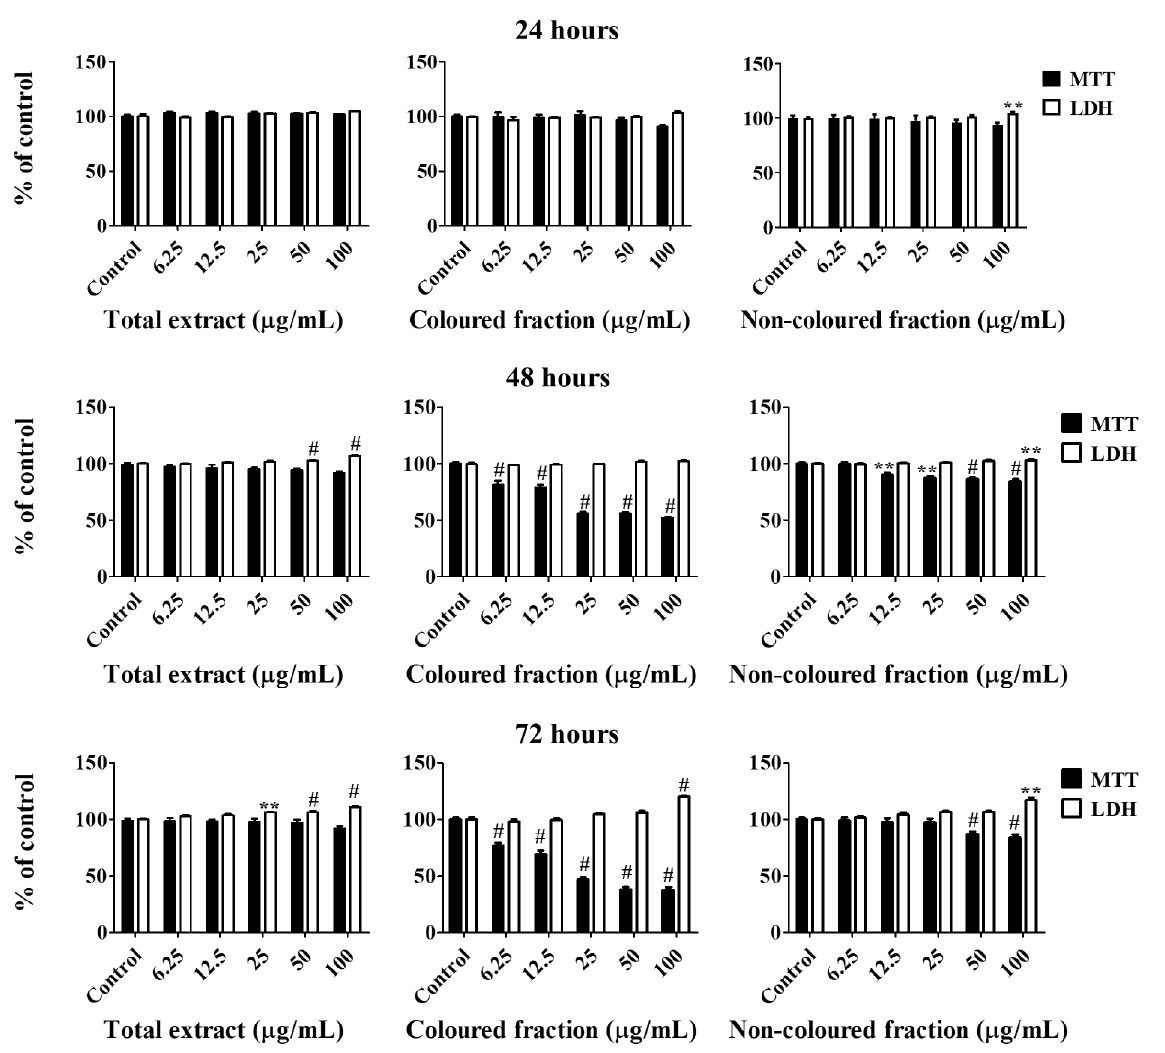
Figure 2. Viability of HepG2 cells assessed by 3-(4,5-dimethylthiazol-2-yl)-2,5-diphenyltetrazolium bromide (MTT) reduction and lactate dehydrogenase (LDH) leakage assays. Cells were treated with each extract for 24, 48 and 72 h. Values show mean ± SEM of six independent assays performed in triplicate compared to the respective control (** p < 0.01 and # p <